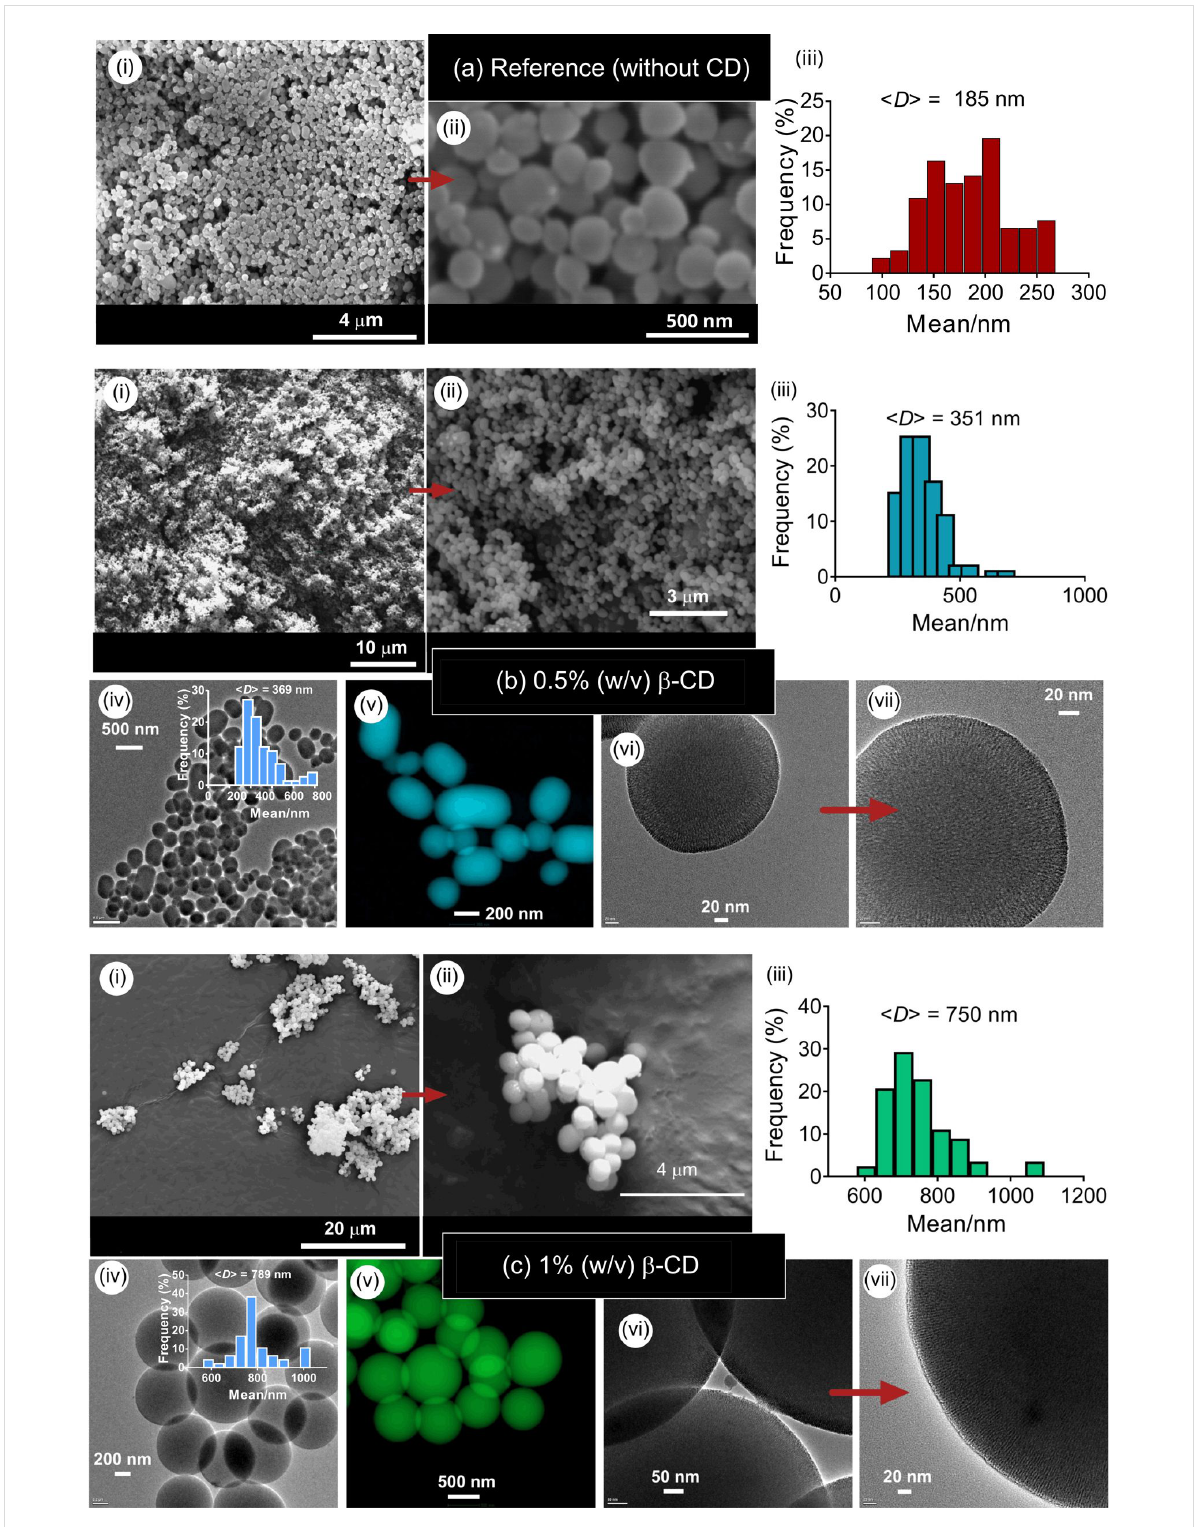
Figure 2: SEM (i, ii), TEM (iv, vi, vii) and colored STEM (v) images and the particle size-distribution plots (iii) of MSNs produced at two different con- centrations of β -CD (MSN-1 (b) and MSN-2 (c)). (a) Reference sample (MSN-20) synthesized in the absence of CD molecules at identical concentra- tions of TEOS (1% (v/v)) and CTAC (0.2% (w/v)). (b) c β -CD = 0.5% (w/v) and r (CD/CTAC) = 5, (c) c β -CD = 1% (w/v) and r (CD/CTAC) = 10. Insets show the size-distribution plots of the respective